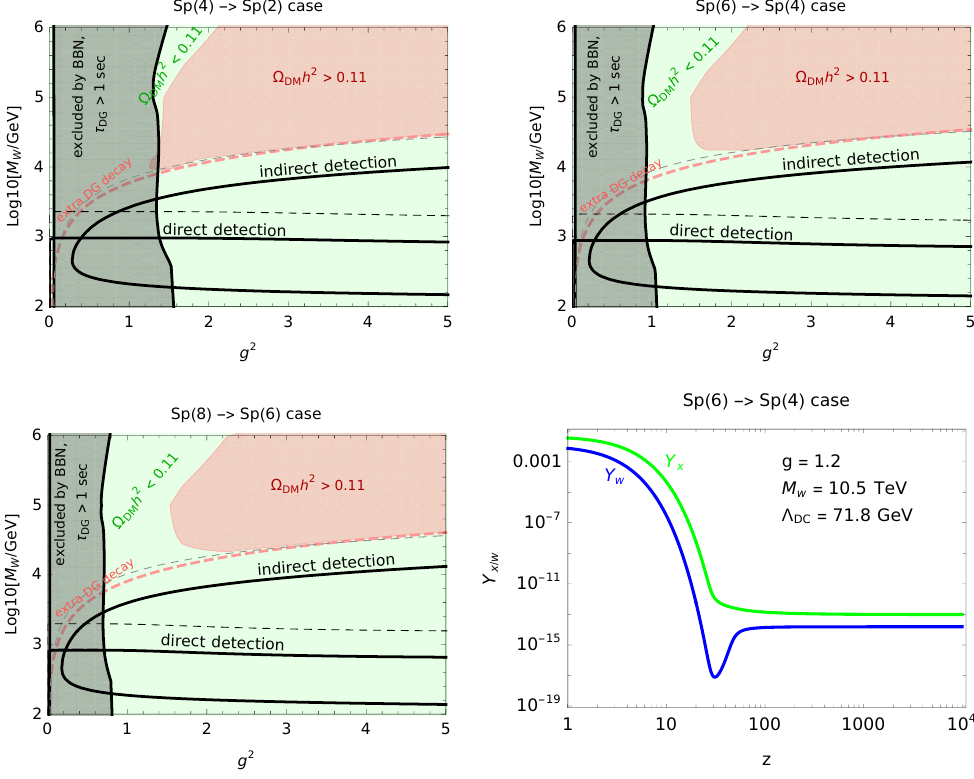
Figure 1 . The DM abundance is reproduced ((cid:10) DM h 2 = 0 : 11) along the boundaries between the red/green regions: the red-solid line is obtained taking into account the dilution factor due to the long-lived glueballs, while the red-dashed line is computed with the assumption that some extra new physics gives fast glueball decays. The current (future) limits of direct and indirect detections are also shown in black solid (dashed) line, respectively. The left gray region is excluded by BBN because of too slow DG decays (of course it is not excluded if we assume extra DG decays). We show predictions for di(cid:11)erent values of N . In the last plot we show the solutions of the Boltzmann equations for values of the parameters ( N = 4, g =1.2, M W =10.5 TeV) such